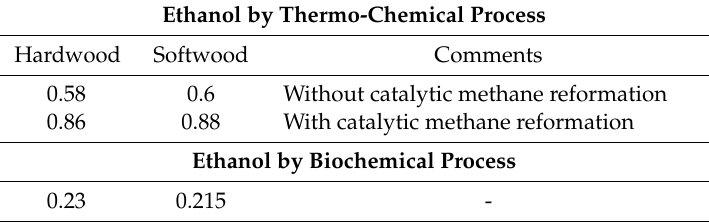
Table 3. Energy ratio of ethanol from hardwood and softwood through different conversion processes (Based on study of